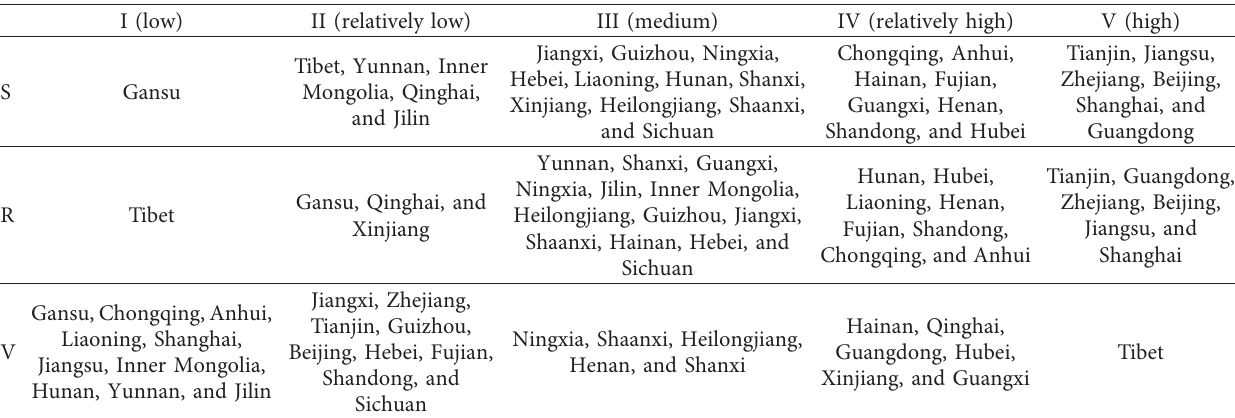
Figure 2: The comparison of the sensitivity, respondence, and vulnerability index of all provinces in 2014 (a) and 2018 (b). Table 2: Classification results and comparison of sensitivity, respondence, and vulnerability index of provinces in